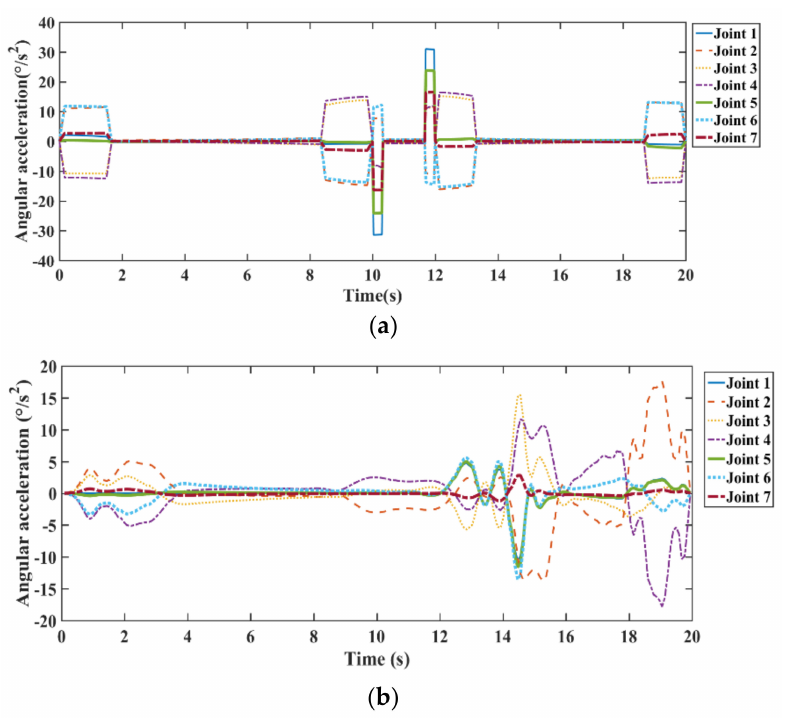
Figure 11. Joint angular acceleration of trajectories. ( a ) Without optimization, ( b ) With optimization.